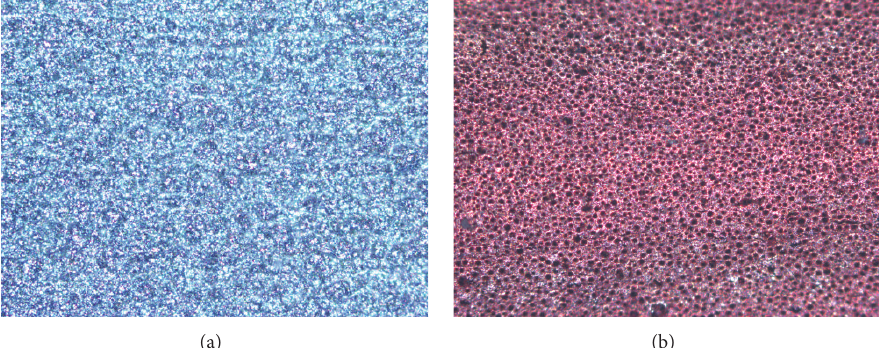
Figure 9: Optical microscope images (magnification × 5) of sintered silver ((a) Sample 10) and copper ((b) Sample 16) ink layers on cardboard